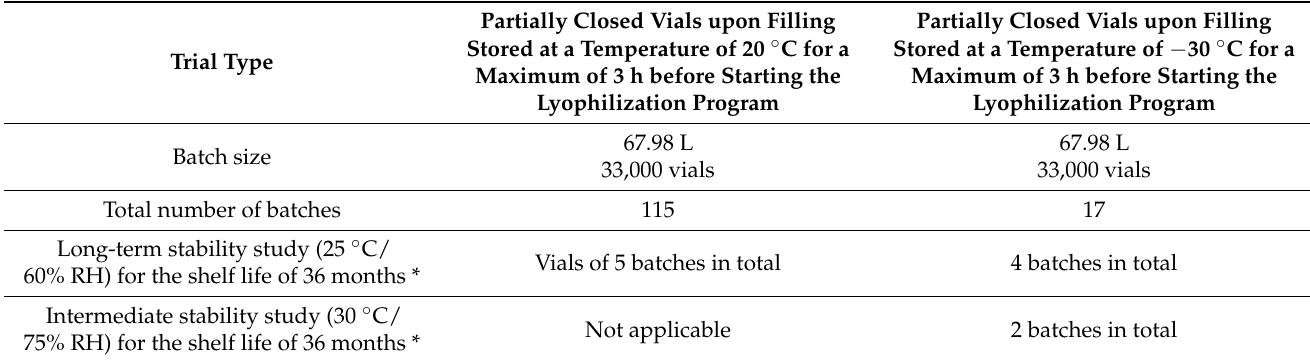
Table 1. Trials conducted for Esomeprazole 40 mg powder for solution for injection/ infusion.